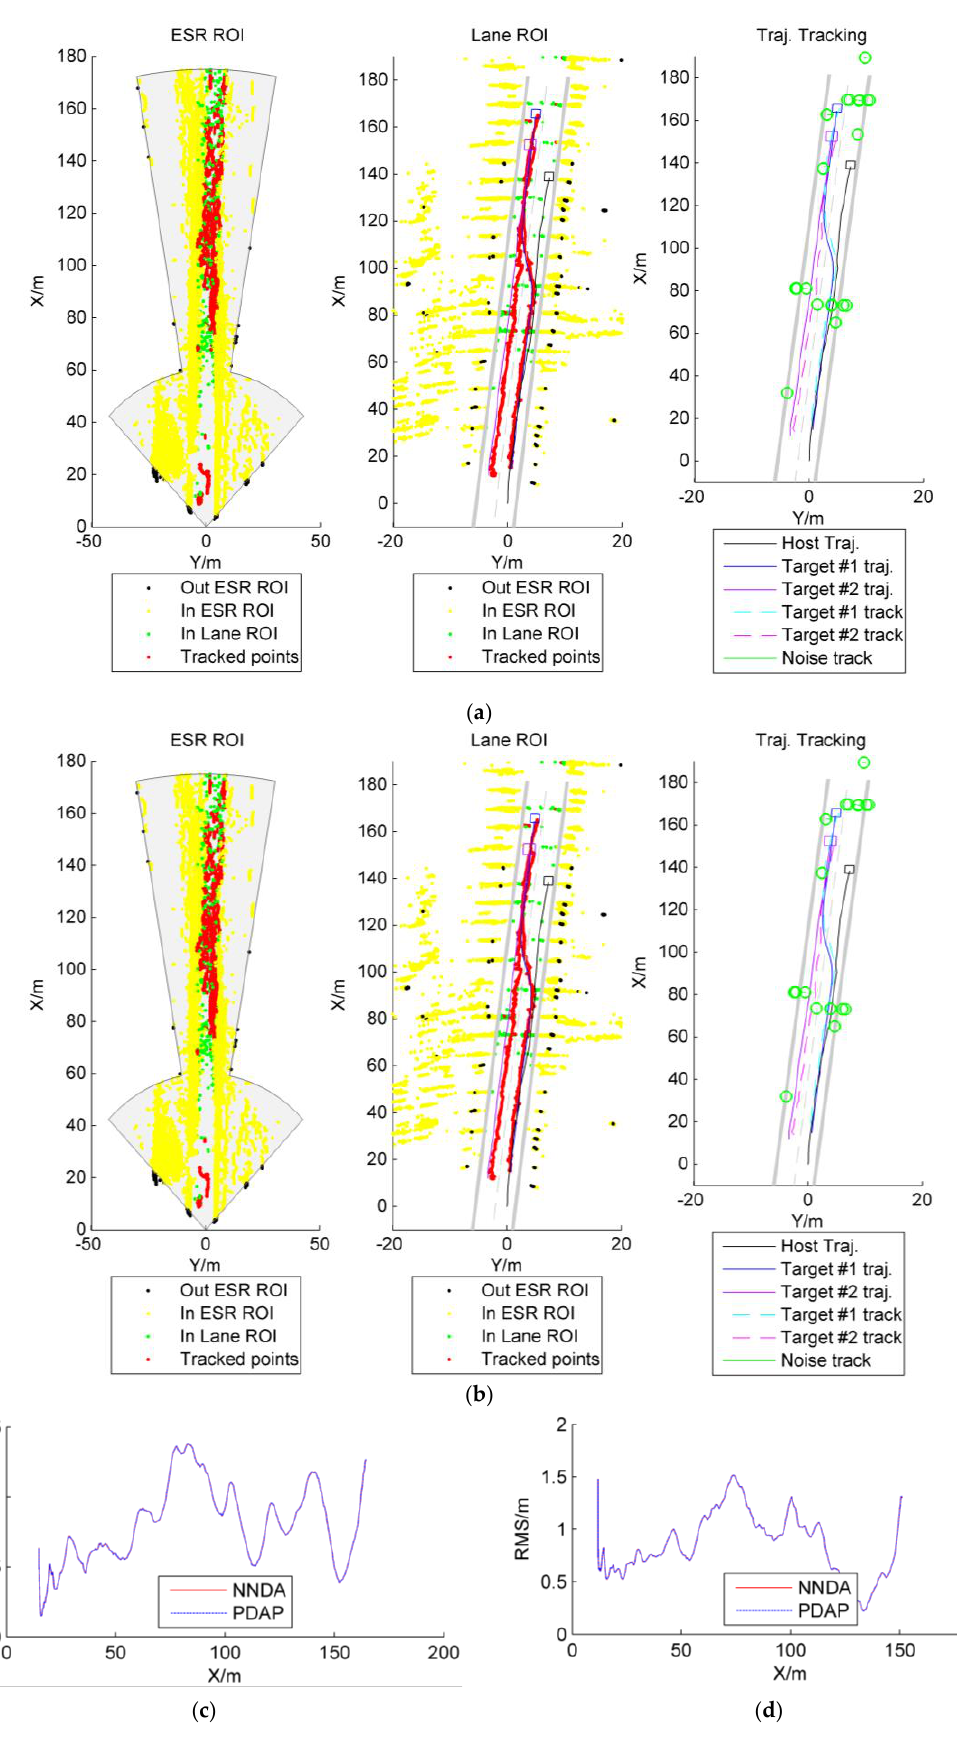
Figure 8. Real test for scenario 4. ( a ) NNDA-CT-UKF multitarget tracking; ( b ) PDAP-CT-UKF multitarget tracking; ( c ) RMS for tracking target #1; ( d ) RMS for tracking target